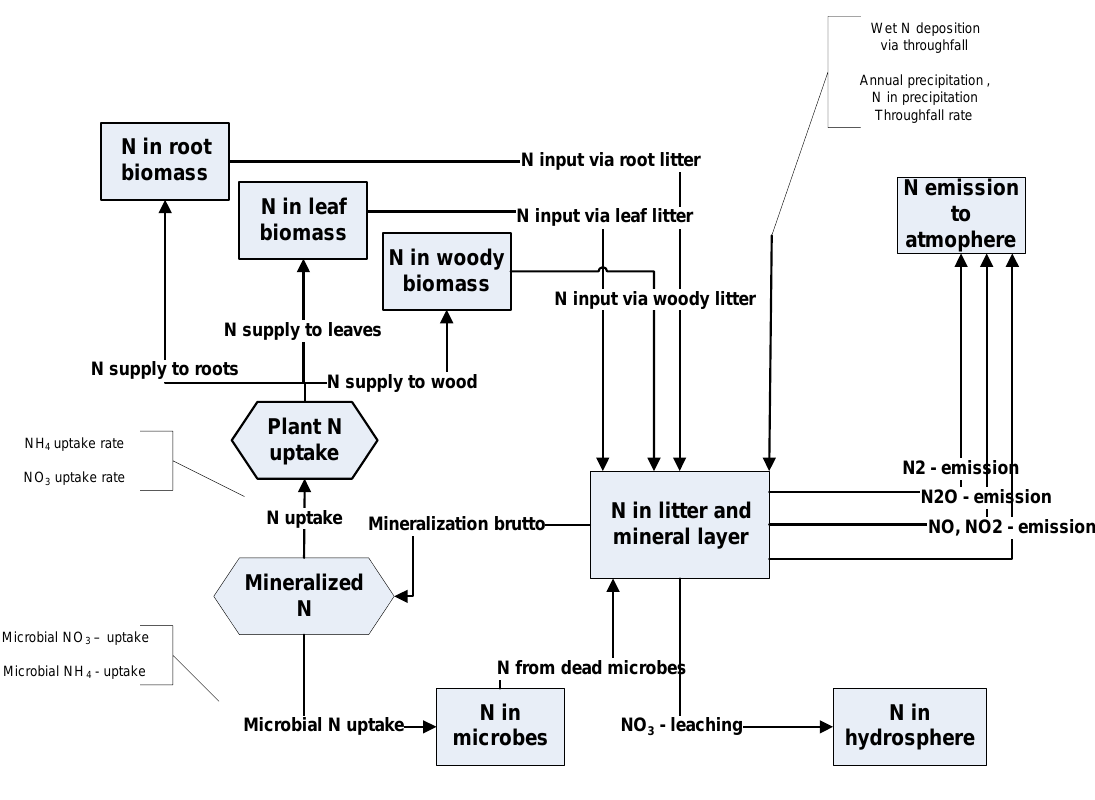
FIGURE 1 . Pools, fluxes, and dispatchers in the